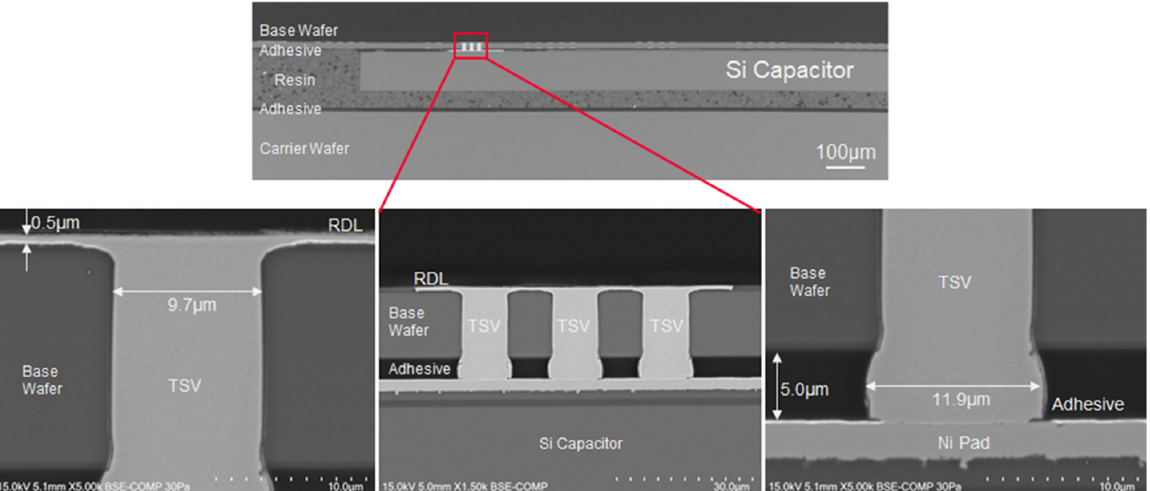
Figure 22. Cross-sectional SEM images of TSV/RDL. Fine plug profile without voids and no signifi- cant oxide residue in the interface between the TSV and Si capacitor pad are observed.